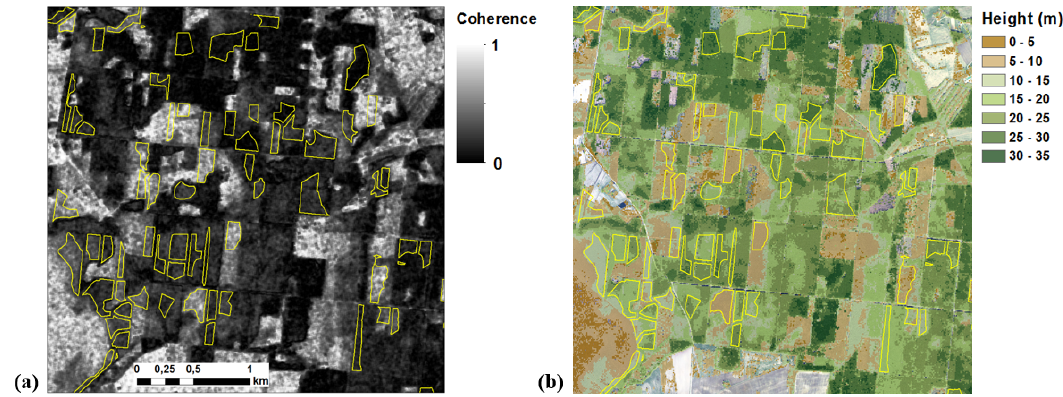
Figure 3. The TanDEM-X coherence image from 4 January 2011 ( a ) and corresponding LiDAR P 90 forest height image from 29 June 2010 ( b ) show the selected forest stands (yellow) on the Peipsiveere test site over a 3.5 × 3.5 km area with center coordinates of 58 ◦ 15 (cid:48) 53.1 (cid:48)(cid:48) N, 27 ◦ 23 (cid:48) 10.8 (cid:48)(cid:48)